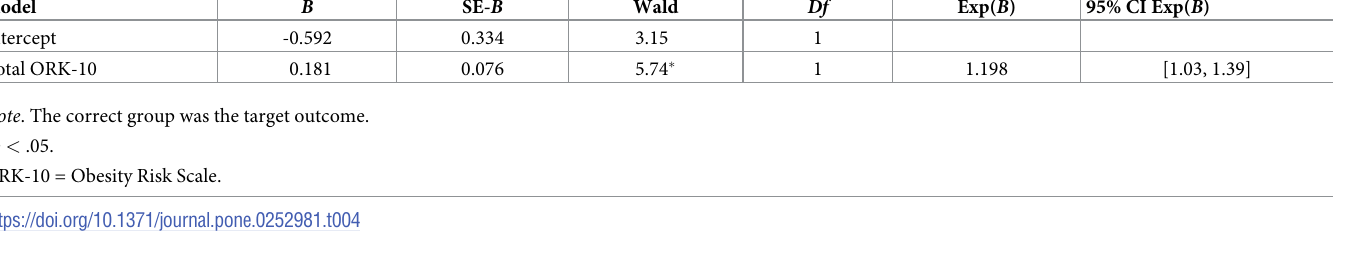
Table 4. Predictors of correct classification using the parent report of child weight with the Likert scale.